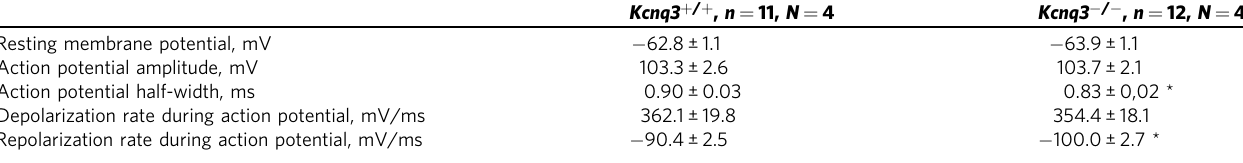
Table 1 Excitability of pyramidal cells.